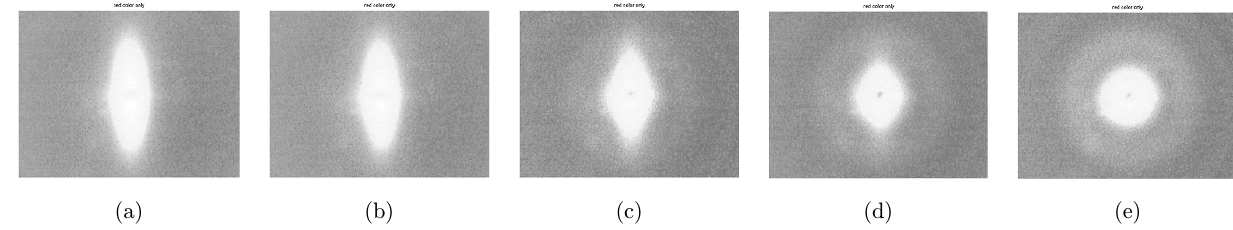
Fig. 4. The di®raction patterns for blood samples of the rat 3 and the di®erent values of \p" (the fraction of cells treated with GA): p ¼